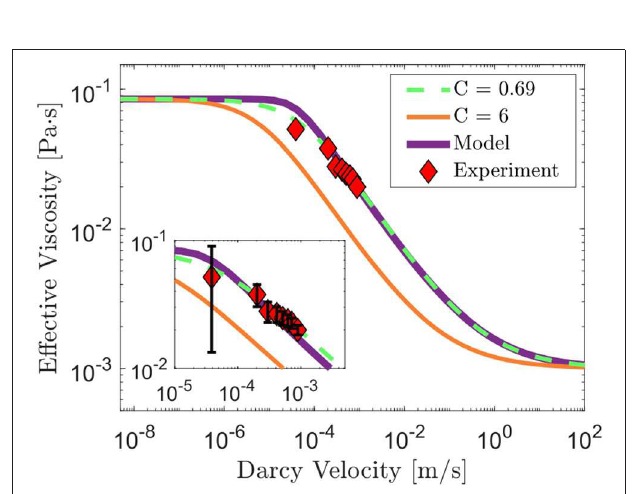
FIGURE 6 | Comparison of the experimental measurements (red diamonds) with the proposed model (purple solid line). The model is calculated for a pipe of radius R 0.62 mm. Additionally, the correlations of Cannella et al. [ 19] = ( C 6) and Hirasaki and Pope [20] ( C 0.69) are shown. The latter was = = defined from packed beds of monodisperse spheres.